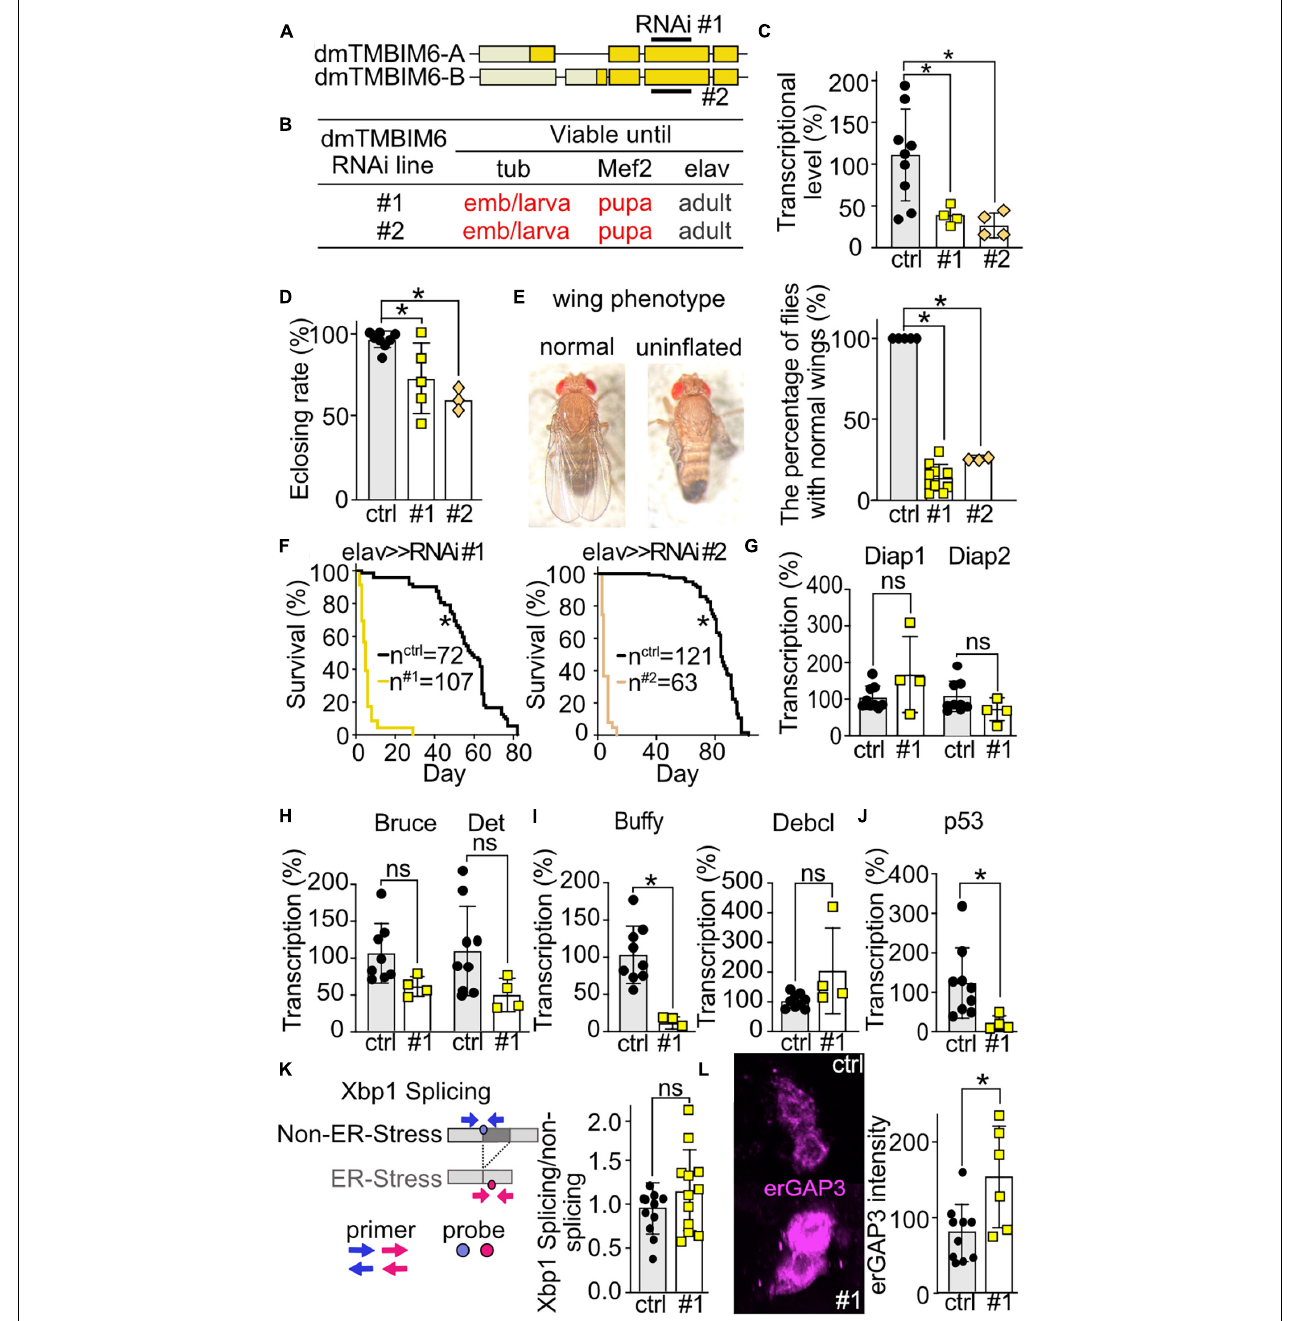
FIGURE 6 | Ubiquitous or muscular knockdown of dTmbim6 leads to developmental lethality while neural knockdown affects wing inflation and dramatically shortens lifespan which correlates with increased ER Ca 2 + levels but not ER stress. (A) Splicing isoforms of dTmbim6. Lighter color represents the UTR and the darker color the open reading frame. The targeting sequence of the two RNAi lines is indicated. (B) Viability of dTmbim6 KD flies in two RNAi lines with the indicated Gal4 drivers. Red means death. (C) KD efficiency of UAS-dTmbim6-RNAi (#1, #2) assessed by qPCR from whole Mef2 > > dTmbim6-RNAi L3 larvae. (D) Eclosion rate of elav > > dTmbim6-RNAi flies. (E) Examples of a fly with normal wings and a fly with uninflated wings. Percentage of elav > > dTmbim6-RNAi flies with normal wings. (F) Lifespan of elav > > dTmbim6-RNAi flies. mRNA levels of (G,H) inhibitor of apoptosis (IAP) proteins, (I) Bcl-2 family members and (J) p53 of elav > > dTmbim6-RNAi #1 flies. (K) ER stress was quantified by detecting spliced and unspliced Xbp1 using qPCR in the heads of elav > > dTmbim6-RNAi #1 flies. (L) ER Ca 2 + levels quantified by erGAP3 fluorescence in Pdf neurons of Pdf > > dTmbim6-RNAi #1 flies. Ctrl, UAS-Always-early-RNAi control group. Scale bars in (L) , 1 µ m. Bars in (C–E,G–L) represent the mean ± SD and each dot a group of 5–10 animals in (C) , 50–200 flies in (D,F) , 10 heads in (G–K) , and one brain in (L) . Statistical significance was calculated using One-way ANOVA followed by the Dunnett’s test (C,D,E) , the log-rank test and Gehan–Breslow–Wilcoxon test in (F) , and the independent t test in (G–L) . ns, not significant * p <